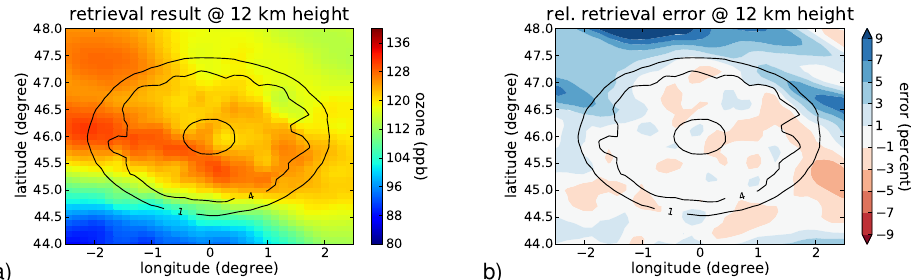
Fig. 13. The retrieval result of a run with advection and perfect a priori knowledge thereof. Panel (a) shows the retrieved ozone values at 12 km height while panel (b) depicts the relative error in percent compared to the true values. The number of tangent points within the depicted volume elements is overlaid as a contour plot.